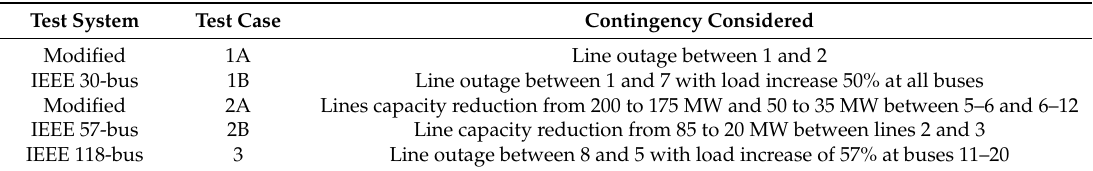
Table 1. Details of simulated test systems with test cases.